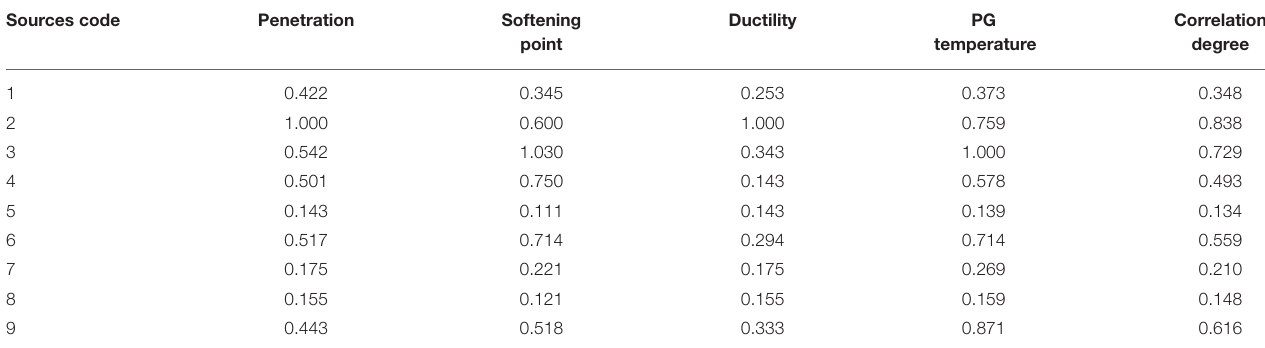
TABLE 5 | Result of correlation coefficient and degree of